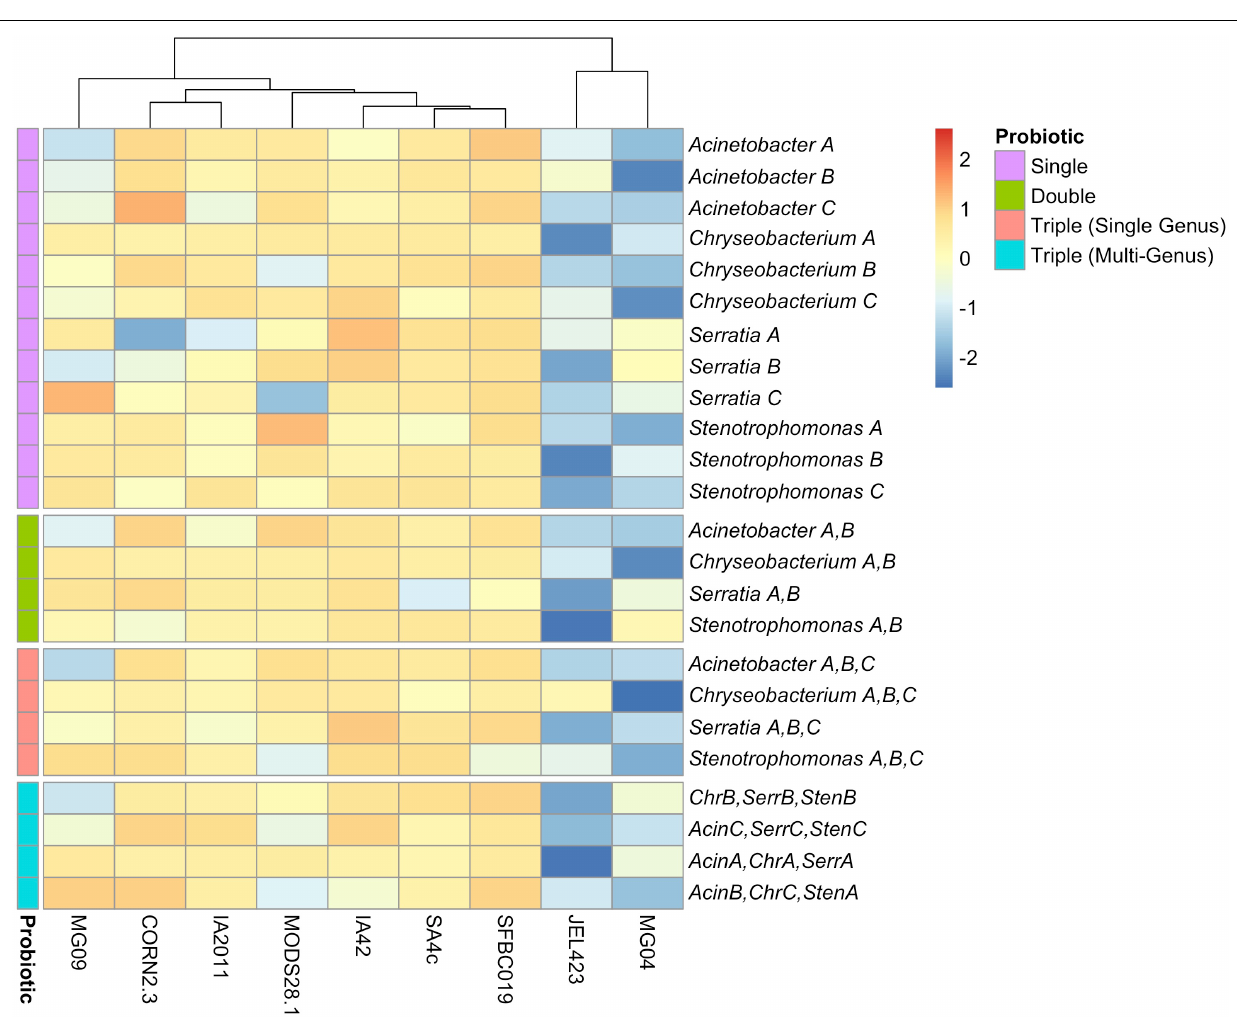
FIGURE 2 | Heatmap of inhibition scores across nine Bd isolates for all probiotic types. Rows are ordered based on increasing probiotic complexity, from single bacterial isolate to multi-genus triple-isolate probiotics. Probiotics are color-coded according to complexity (see “Probiotic” legend). Columns have been clustered according to similarity of inhibition profiles among Bd isolates. Data are scaled by row to permit comparison of inhibition strength across Bd isolates for each probiotic. Multi-isolate probiotic abbreviations: Chr , Chryseobacterium; Acin , Acinetobacter; Serr , Serratia; Sten ,